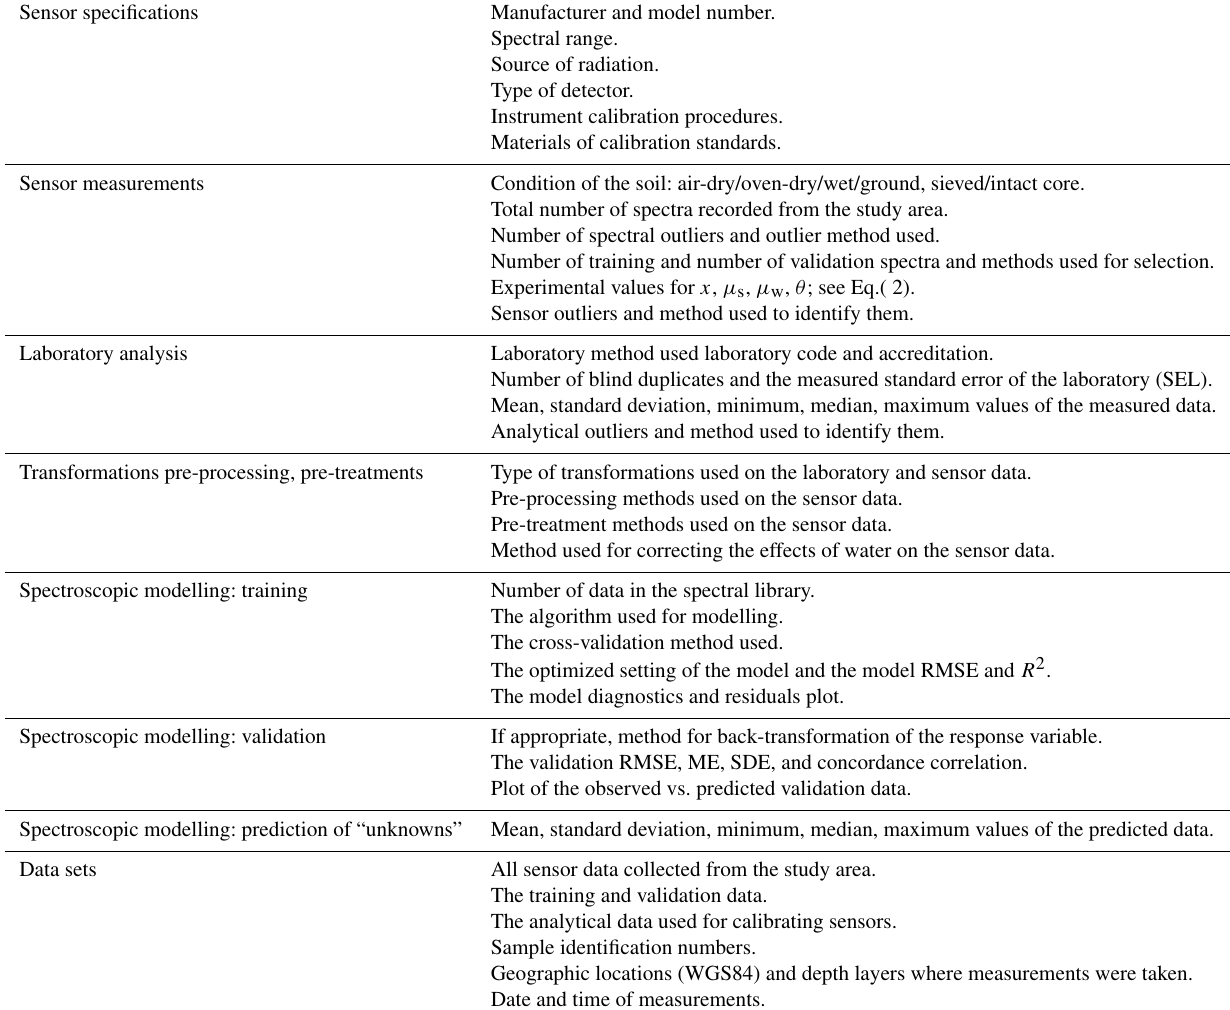
Table 5. Data to be recorded for auditing and verification in a soil organic C accounting method. Sensor